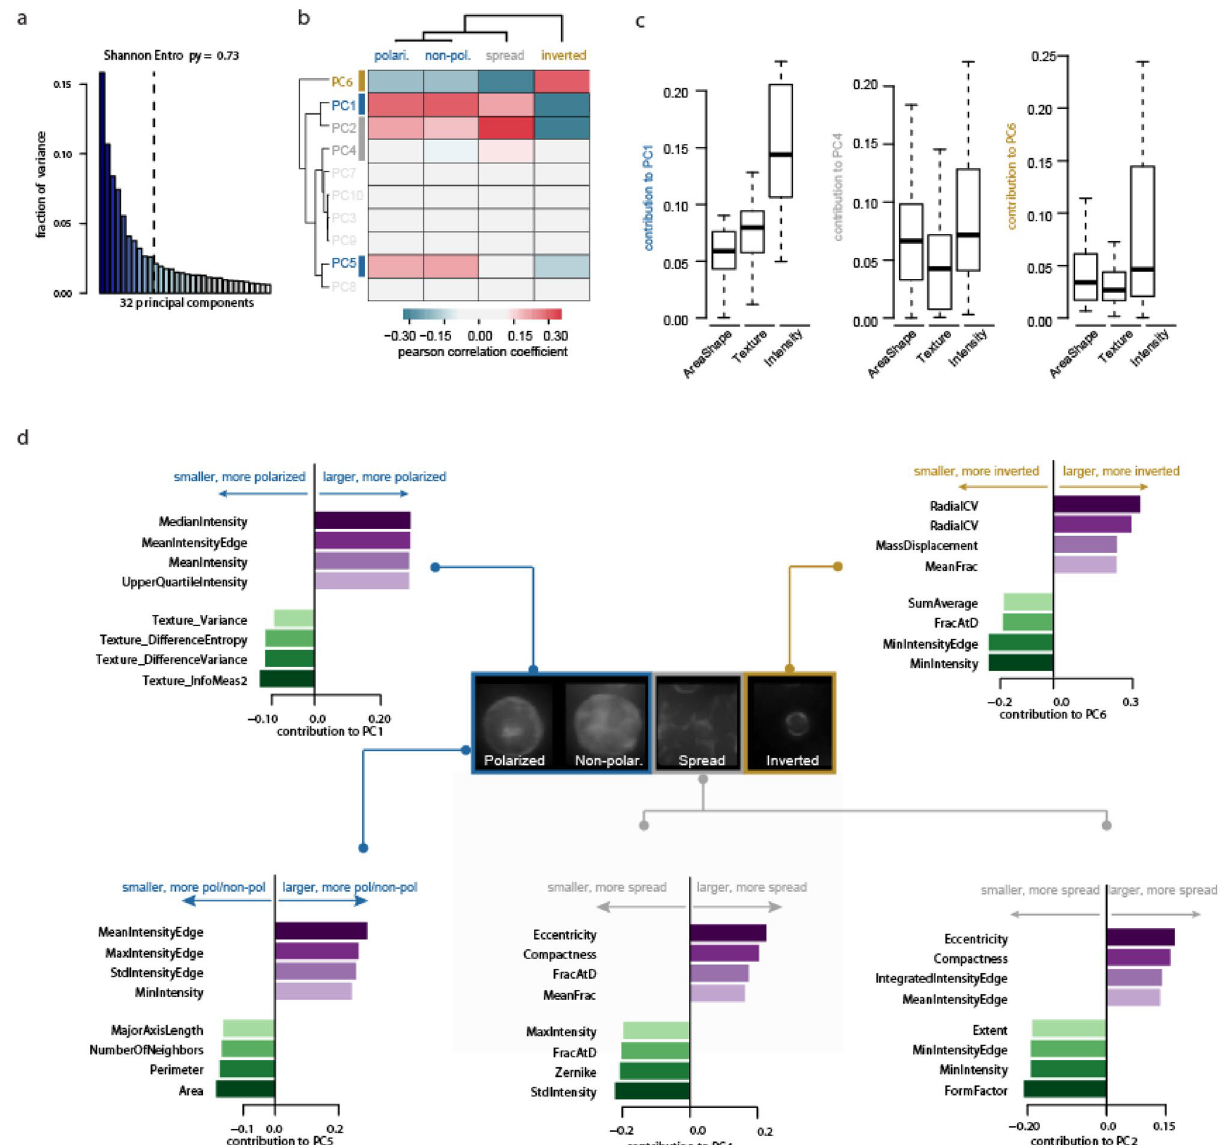
Figure 2. Unsupervised analysis of the most frequent phenotypes. The top 10 principal components (PCs) obtained from the singular value decomposition analysis of the 102 measurements across 56,892 colonies captures 73% of the variance in the data and are used for downstream analysis ( a ). Correlation analysis between the ten first left singular vectors and the frequency of visually identified phenotypes within each well ( b ). Distribution of the absolute contribution of the 102 measurements grouped in three categories (areashape, texture and intensity) to selected PCs ( c ). Identification of the measurements contributing most positively and most negatively to the selected PCs as indicative imaging features having most and least influence on selected PCs ( d